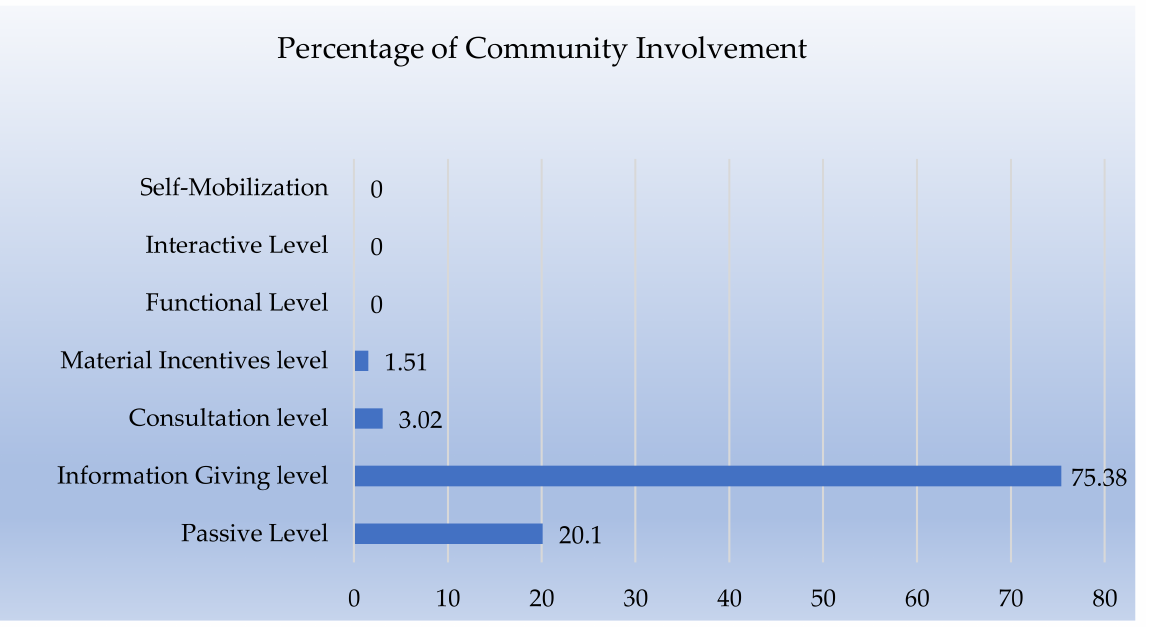
Figure 2. Percentage of respondents agreeing to the community participation experience (N =